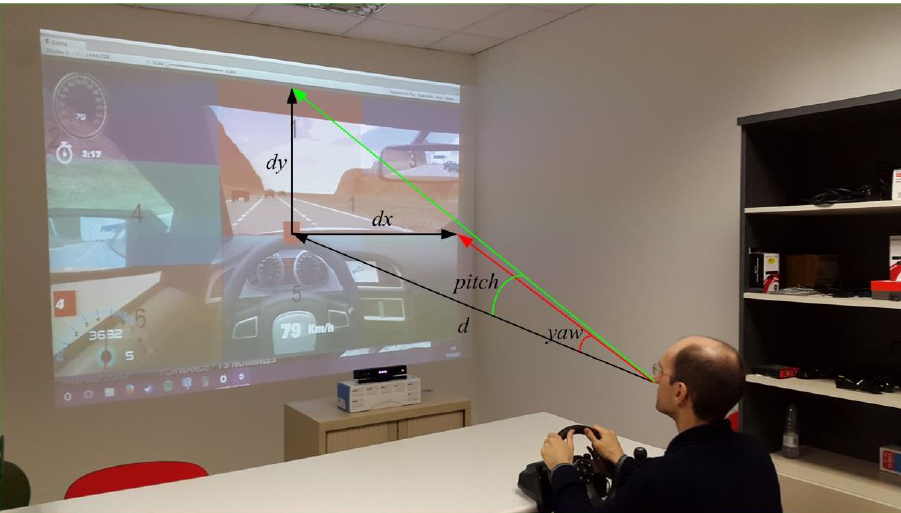
Figure 1. Transformation from degrees of yaw and pitch to cm in the visualization screen.